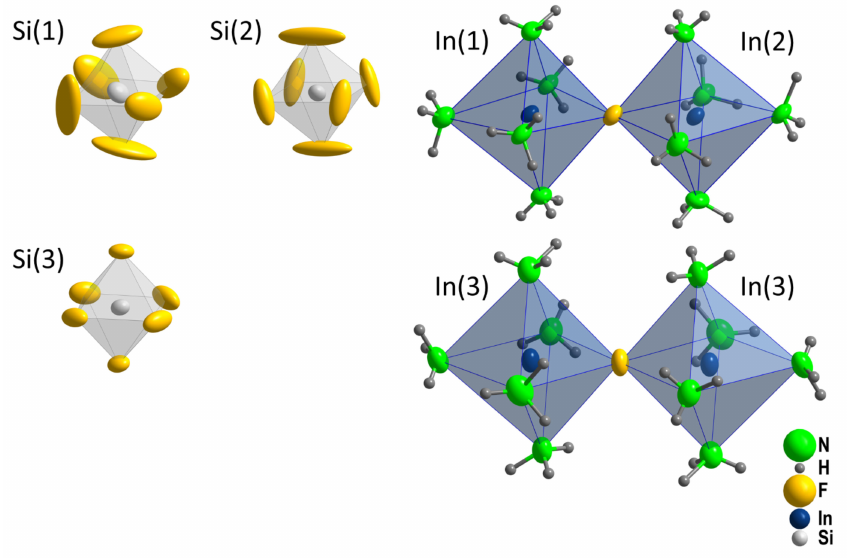
Figure 8. Coordination of the cations in [In 2 F(NH 3 ) 10 ] 2 [SiF 6 ] 5 · 2 NH 3 . Atoms are represented by anisotropic displacement ellipsoids (probability of 70%), taken from the refinement of the diffraction data gathered at 100 K.